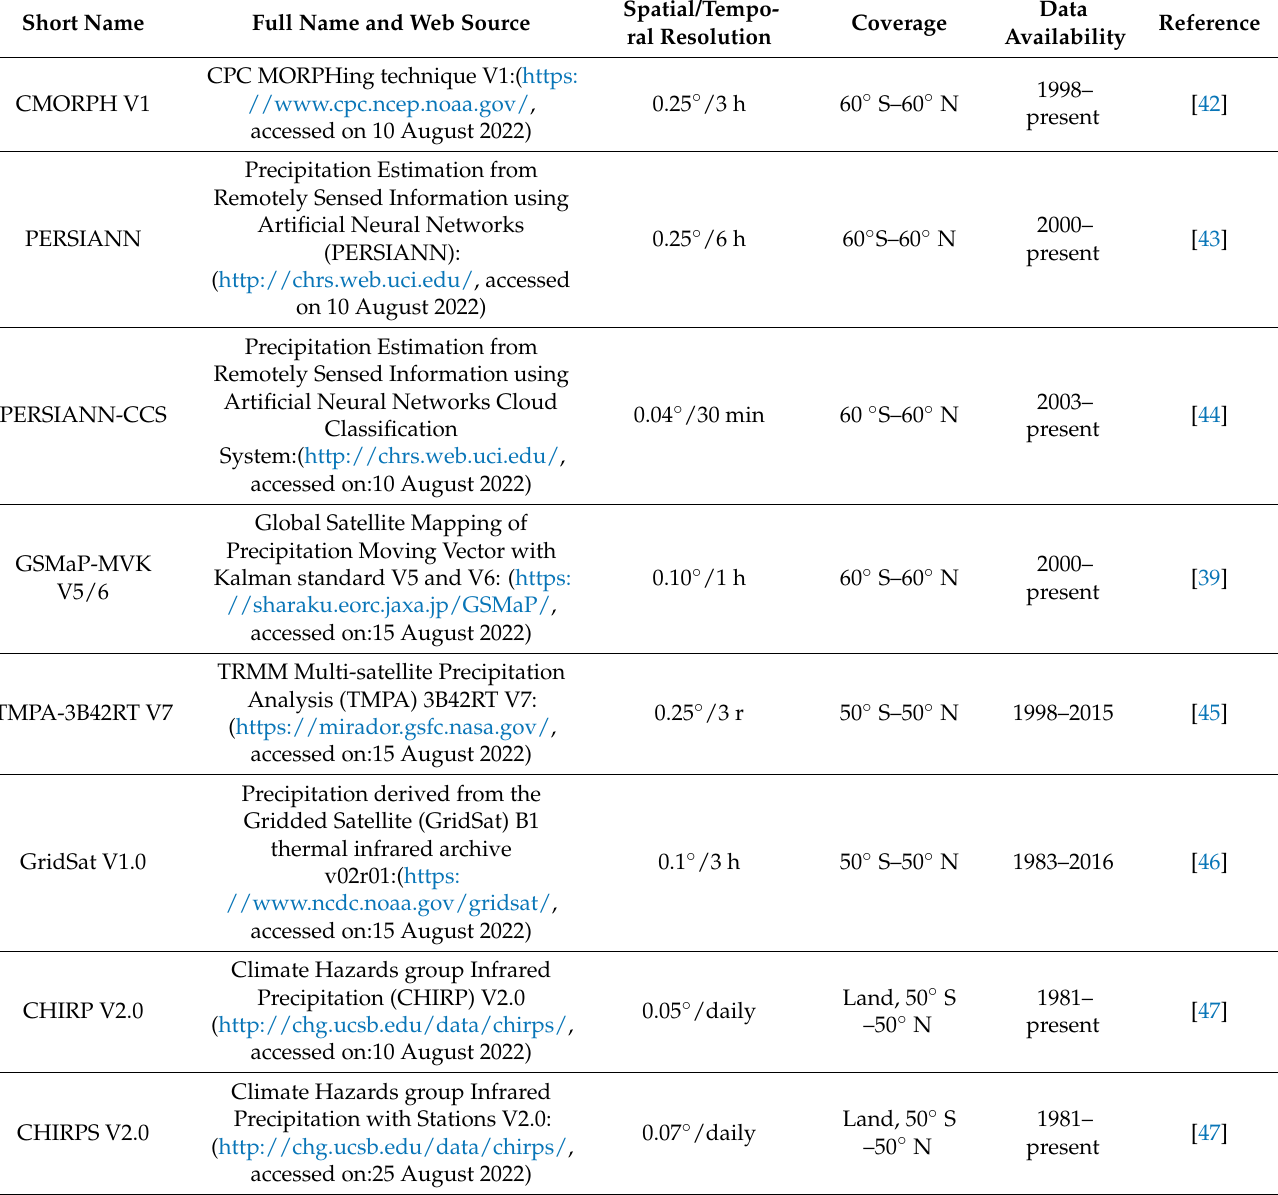
Table 1. Characteristics of the most widely used global and quasi-global satellite precipitation